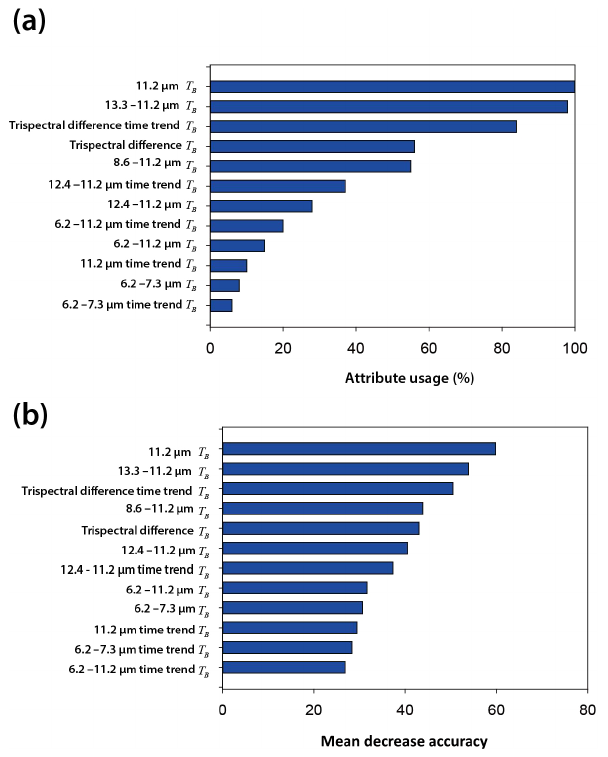
Figure 3. (a) Attribute usage information in percentage by inter- est field produced in the DT model. (b) Mean decrease accuracy (MDA) in percentage by interest field produced in the RF model. MDA was calculated using out-of-bag (OOB) data when an interest field was randomly permuted. The higher the MDA of an interest field, the more the field contributes to identify CI.